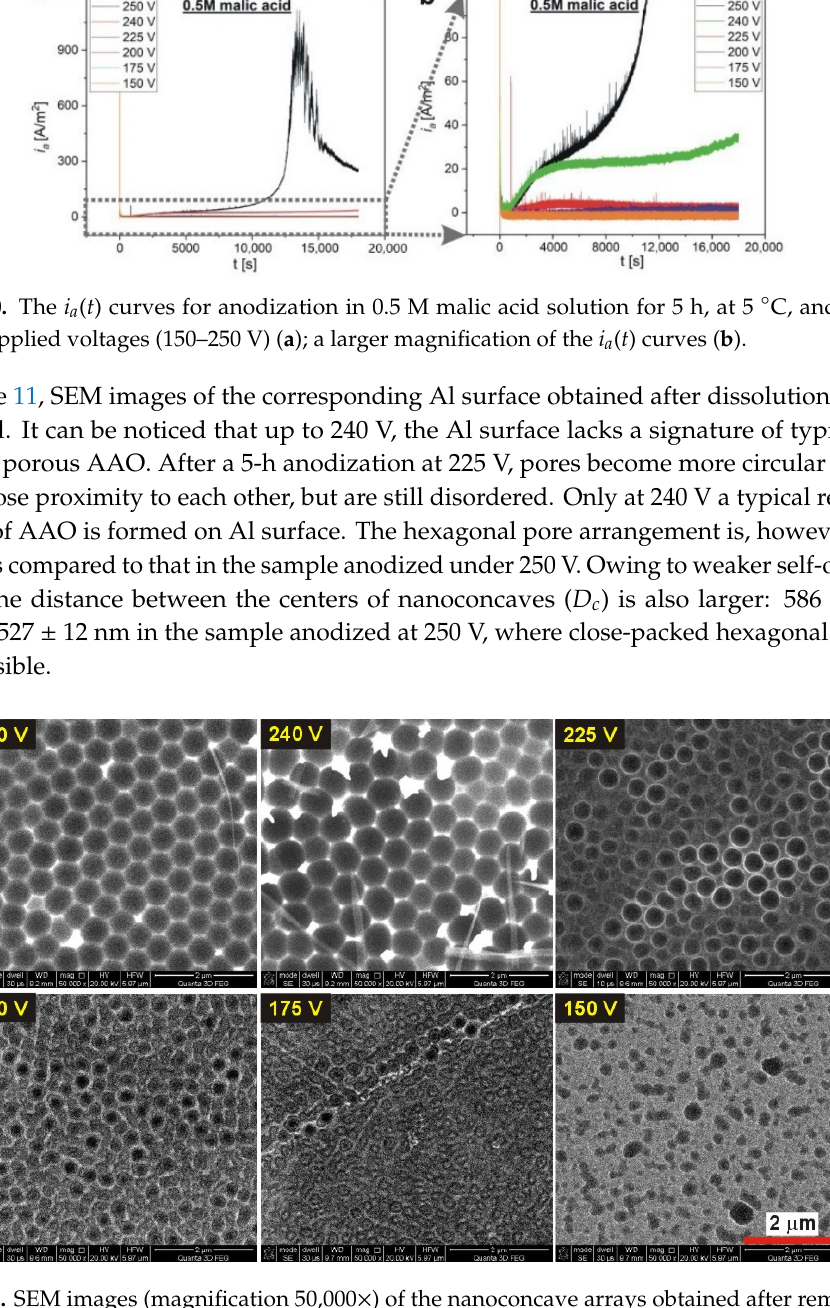
Figure 11. SEM images (magnification 50,000 × ) of the nanoconcave arrays obtained after removal of AAO in the samples anodized under various applied voltage in 0.5 M malic acid solution for 5 h, at 5 ◦ C (the red scale bar = 2 µ m in the bottom right corner is for all